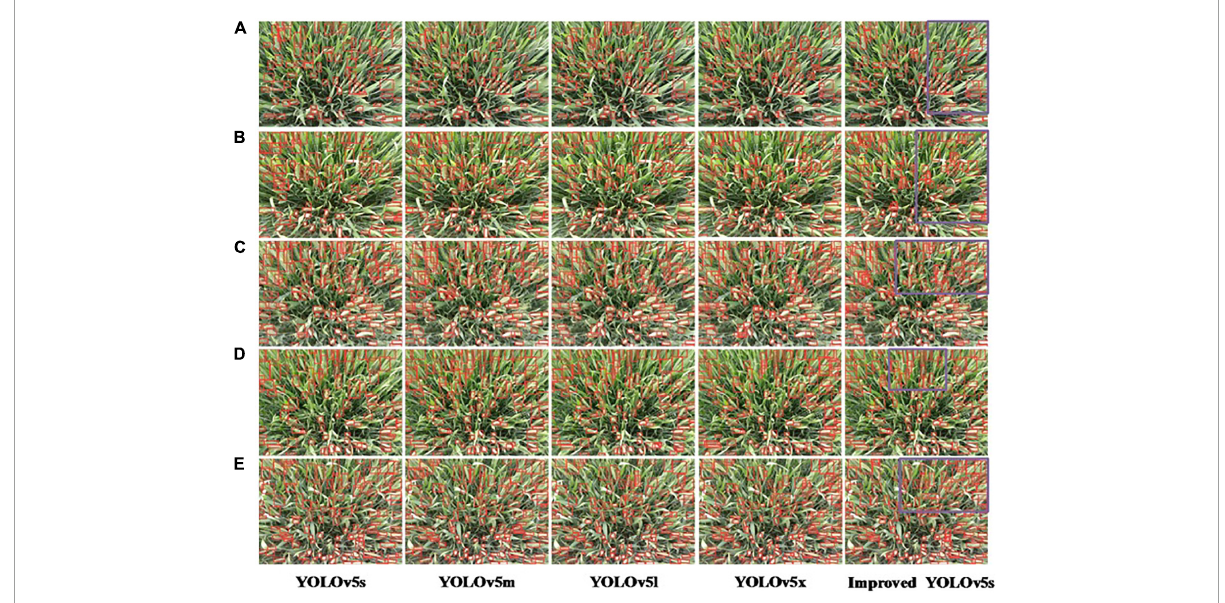
FIGURE8 Qualitative analysis of experimental results of YOLOv5 algorithm. (A–E) Represent the number of images.